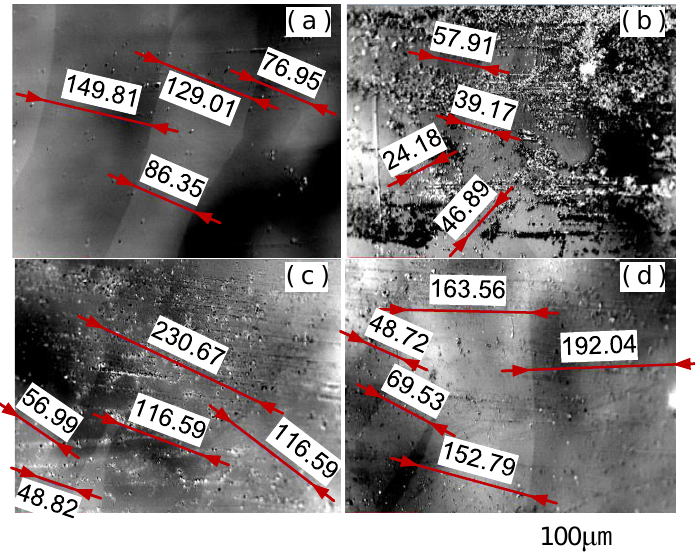
Figure 9. Magnetic domain image of samples before and after W-EDM processing. ( a ) Original ribbon, ( b ) 0 mm, ( c ) 1 mm, and ( d ) 3 mm from the cut edge.